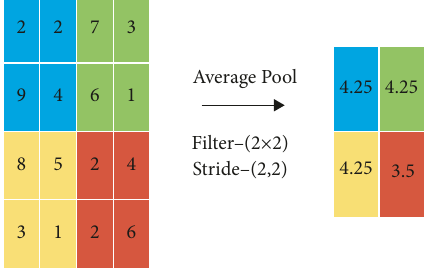
Figure 5: Diagram of average pooling